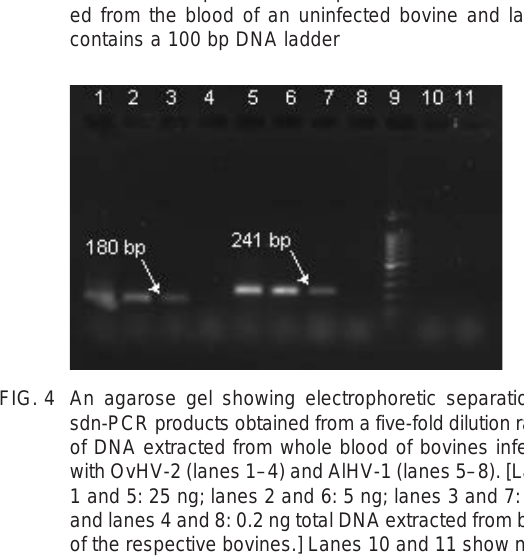
FIG. 6 Agarose gel electrophoresis of AlHV-1-specific sdn-PCR products. The reaction was performed on a 200-fold dilu- tion range of template. The latter was 307 bp gel purified amplicons obtained by performing the MCFV-PCR on DNA extracted from an AlHV-1-infected bovine. Indicated are amplicons derived from 80 pg (lane 1); 0.4 pg